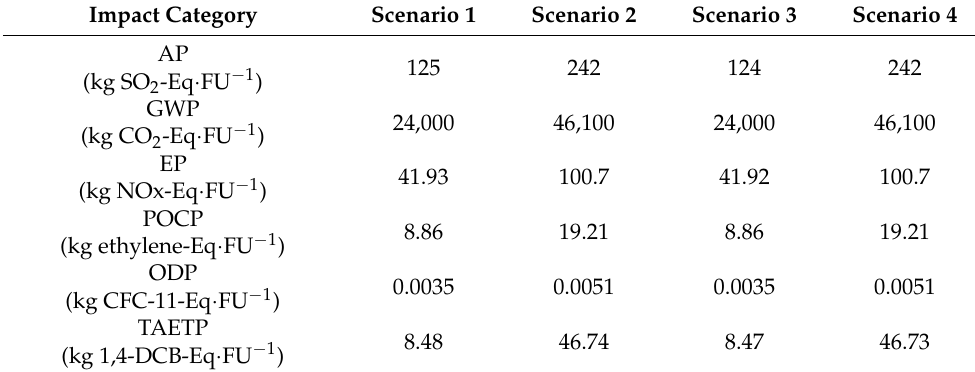
Table 4. Life Cycle Impact assessment for the four